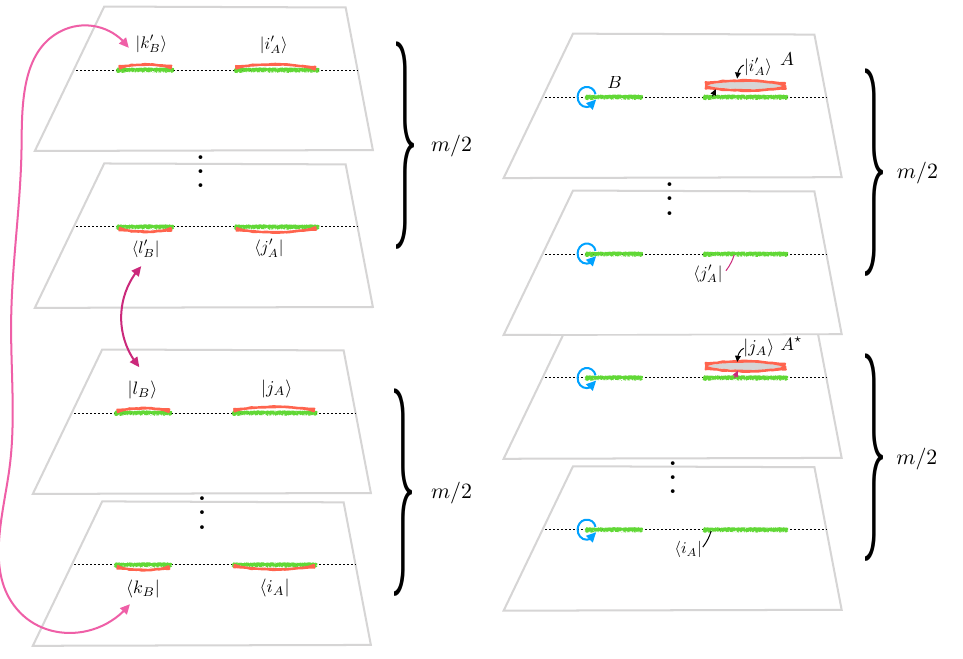
Figure 7 . ( Left ) Path integral that defines the reduced density (4.5) matrix of the state (4.3) for the factors AA ? . The arrows indicate gluings and i 0 , j 0 , j A , i A are left free. Several gluings, A A involving replicas in the . . . have not been shown, but these happen on both the A and B cuts in a hopefully obvious way. There are m replicas and m must be even. ( Right ) A simple deformation of the left picture making clear that the result is a path integral on M m with cuts on the zeroth and m/ 2 ’th replica. Our conventions are such that moving from the top of A, B at Euclidean time τ = (cid:15) to the bottom of A, B at τ = − (cid:15) decreases the replica index and shifts upwards.